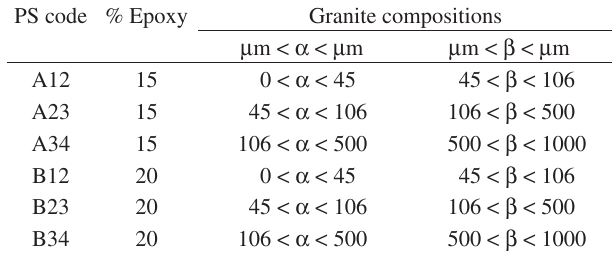
Table 2. Process